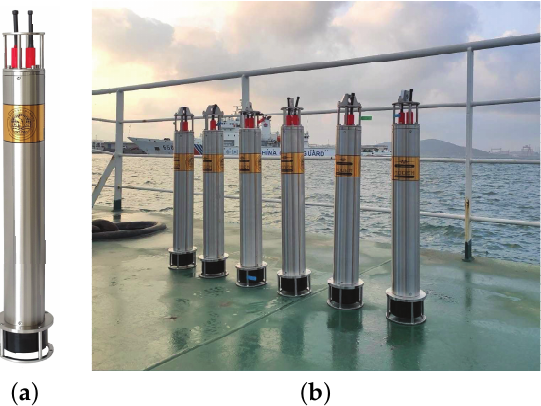
Figure 18. Illustration of underwater acoustic communication machine (Seatrix Modem). ( a ) Single machine; ( b ) multiple machines.